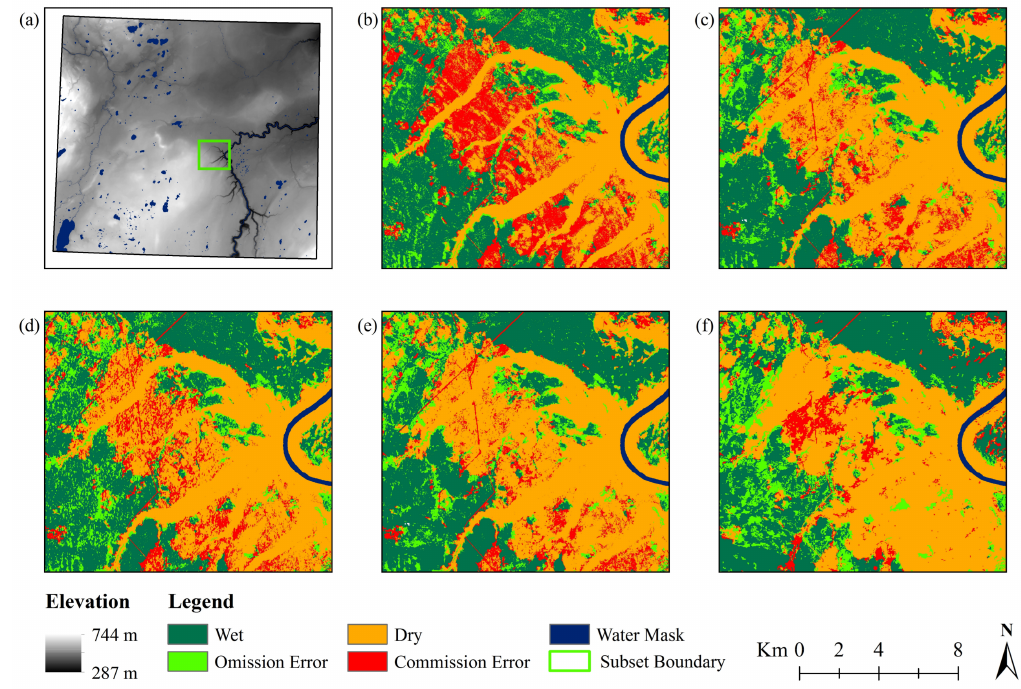
Figure 11. Local variations in classification errors for the area located within a central subsection of the study area delineated by the green box in ( a ), for ( b ) T model , ( c ) TO model , ( d ) TS model , and ( e ) TOS model models, as well as ( f ) the AMWI. Equivalent subsection to that shown in Figure